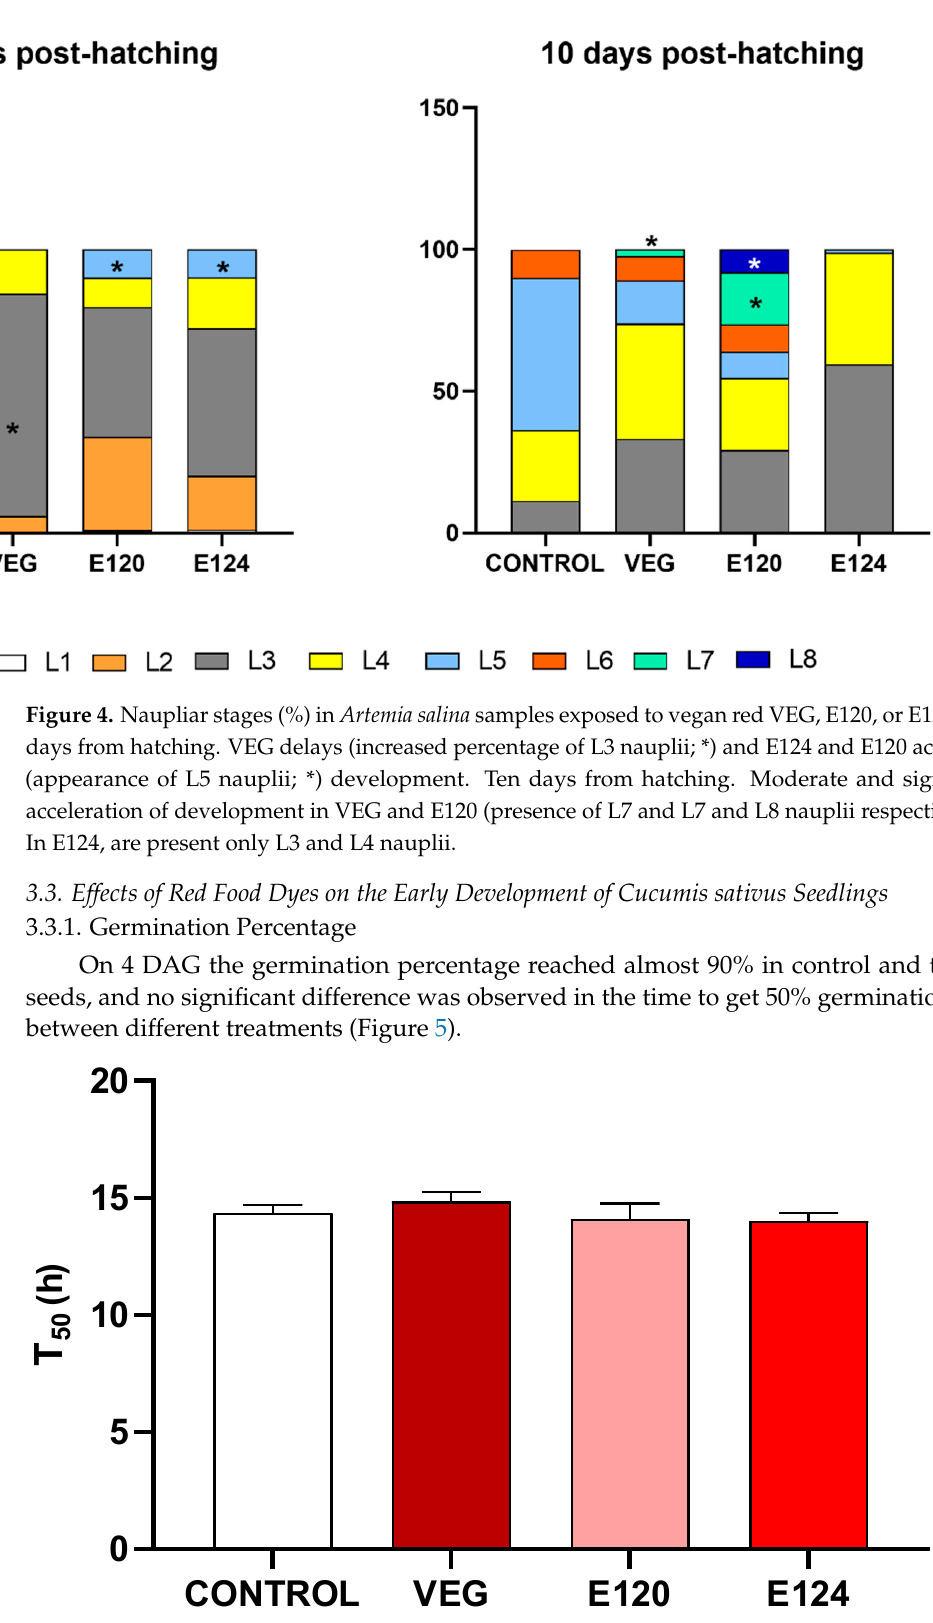
Figure 5. Effect of vegan red VEG, E120, or E124 on the time (h) to obtain a 50% of Cucumis sativus seeds germinated (T 50 ). Data are mean ± SEM ( n = 20). No significant differences are evident among treatments.